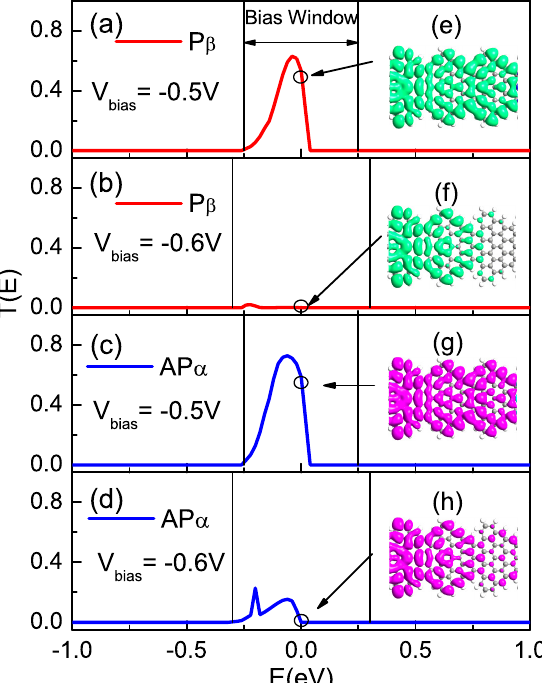
Figure 7. (Color online) Transmission spectra for P β /AP α state under the applied bias ( a , c ) − 0.5 and ( b , d ) − 0.6 V for model M2, respectively. Inset: spin-resolved LDOS at E F , ( e , f ) for P β state and ( g , h ) for AP α state. The region between the black lines is the bias